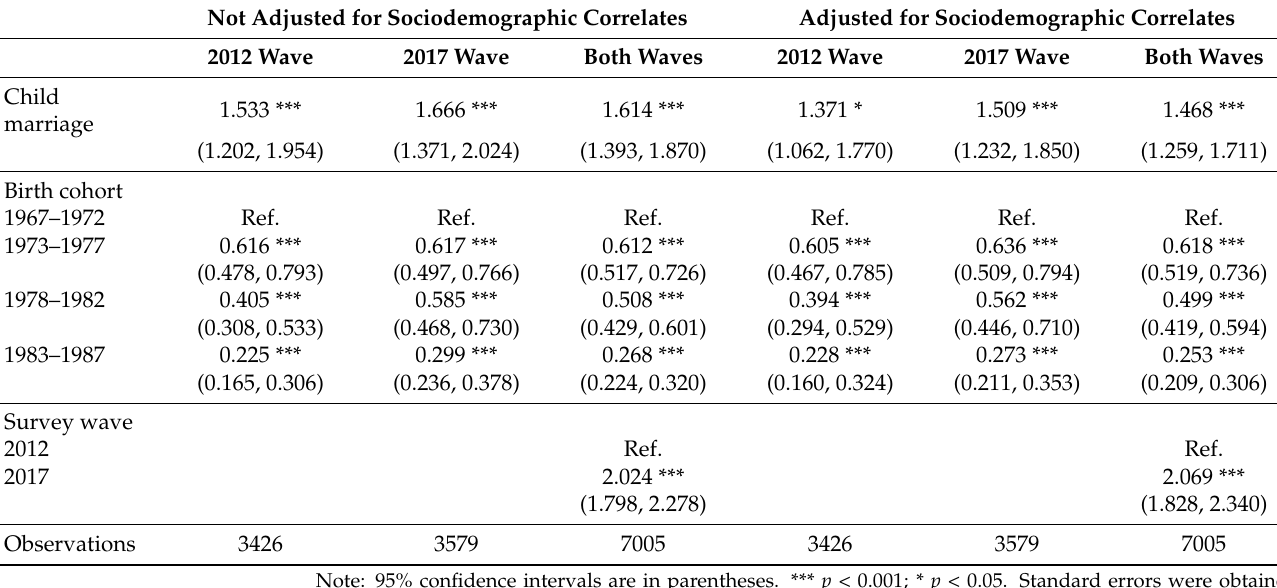
Table 2. Odds ratios in favor being obese for the full sample.